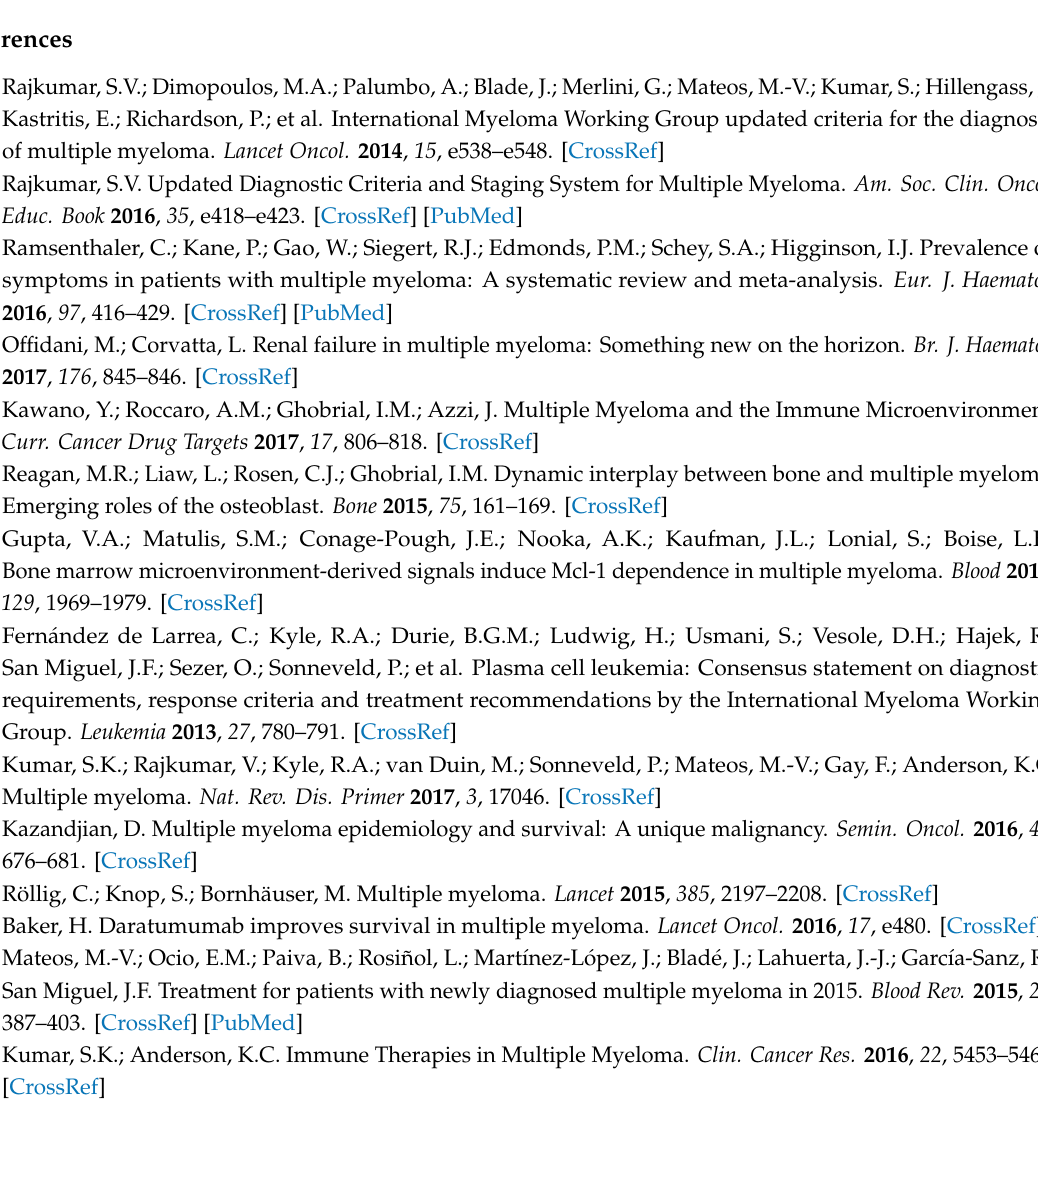
Figure S1: Experimental setup of a 3D BM culture